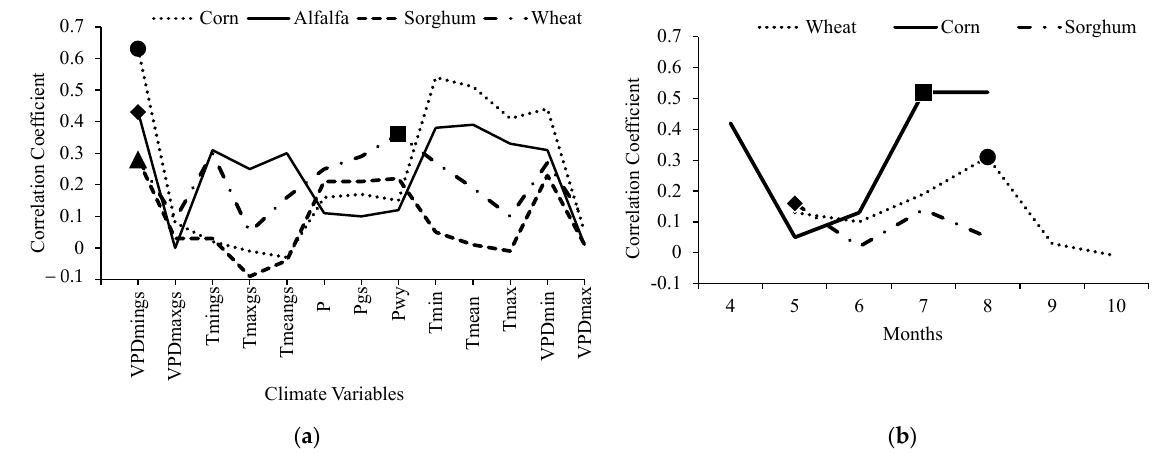
Figure 4. Correlation analysis of ( a ) climate variables and ( b ) NDVI with crop yields for corn, alfalfa, sorghum, and wheat. The highlighted large size markers represent the high correlation coefficient of climate variables with crop yield ( a ) and monthly NDVI with crop yield ( b ).